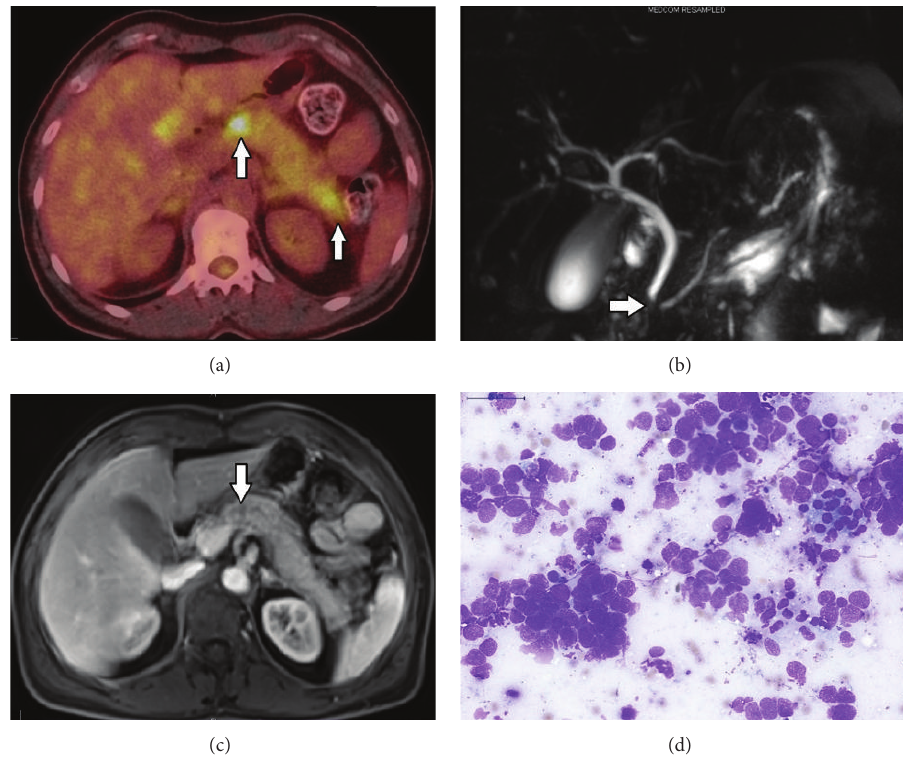
Figure 2: (a) Focal involvement areas of neck and tail of the pancreas on PET-CT (indicated by arrows). (b) Indistinct and nonuniformly circumscribed area of the pancreatic neck on abdominal MRI (arrow). (c) Segmental obliteration of the pancreatic duct on MRCP (arrow) and dilatation to its distal part. (d) Small cell carcinoma as shown by cytopathological examination of EUS-FNA taken from suspected area of the pancreas (MGG, ×